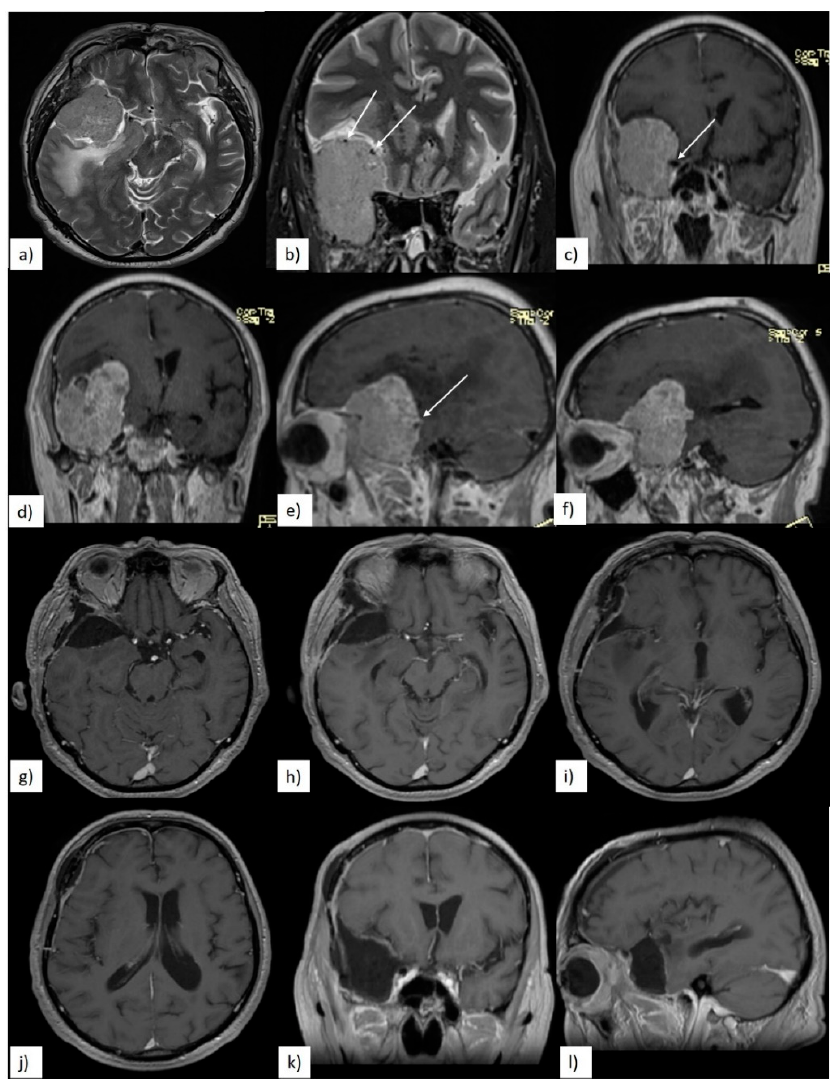
Figure 3. ( a – f ) Preoperative magnetic resonance imaging (MRI) showing partial arterial encasement of ICA- and middle cerebral artery (MCA)-white arrows; ( g – l ) 3-month postoperative T1 contrast MRI showing gross total resection (GTR) of the